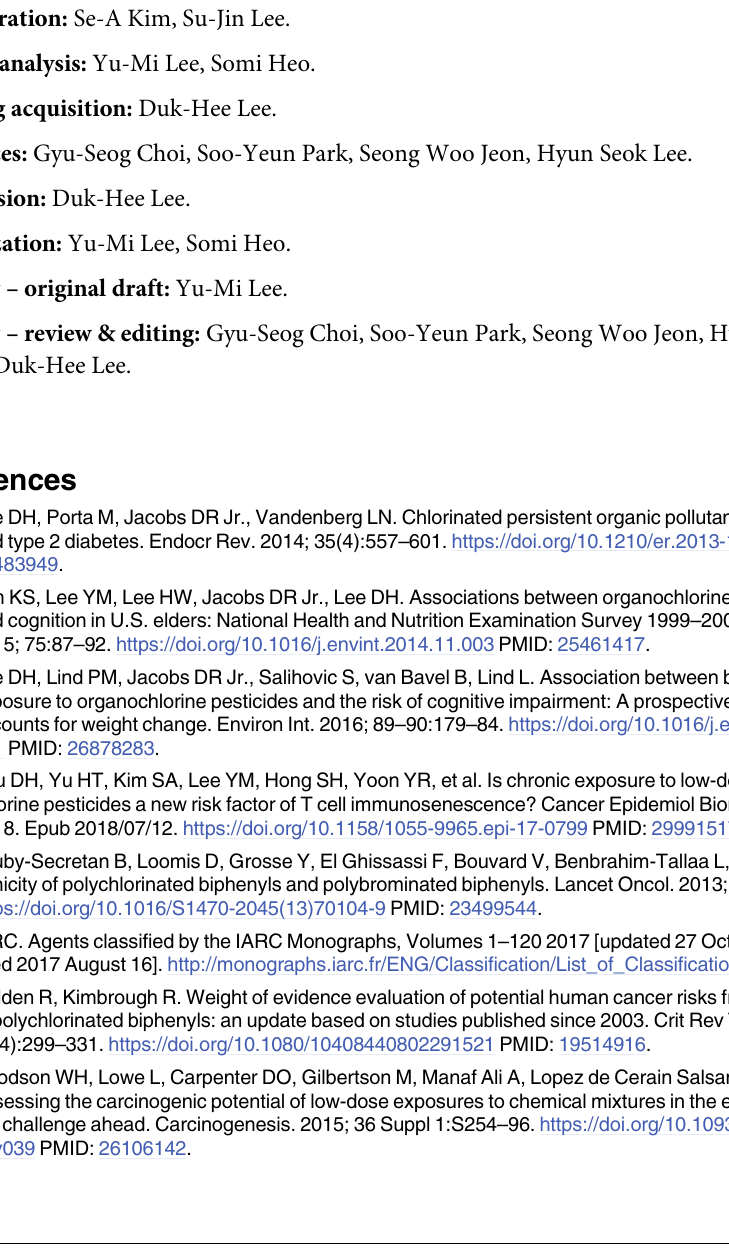
S1 Fig. How to calculate summary measure of